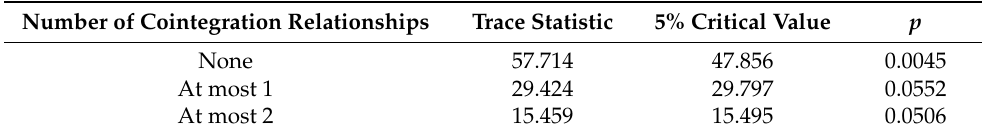
Table 5. Cointegration test results based on the Johansen methodology. Number of Cointegration